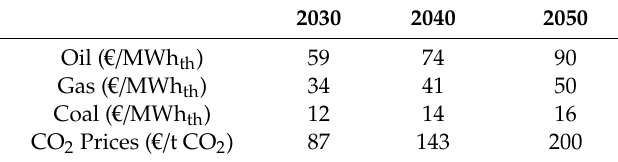
Table A2. Fuel price ( € / MWh th ) and CO 2 price ( € / t CO 2 ) scenario. Source: Reference [28].